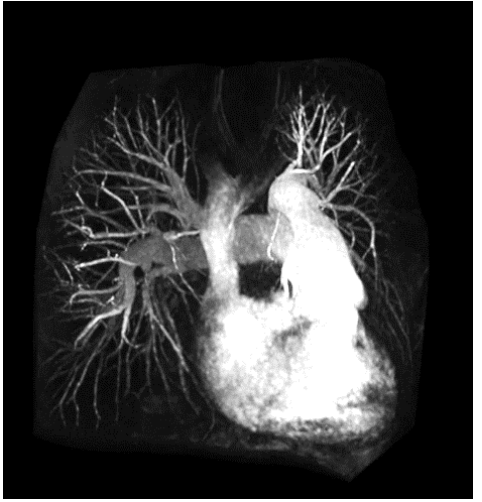
Figure 5. Example angiography (MR) outlining via contrasting the heart chambers and attendant vasculature. Reproduced with permission from Ref. [64].